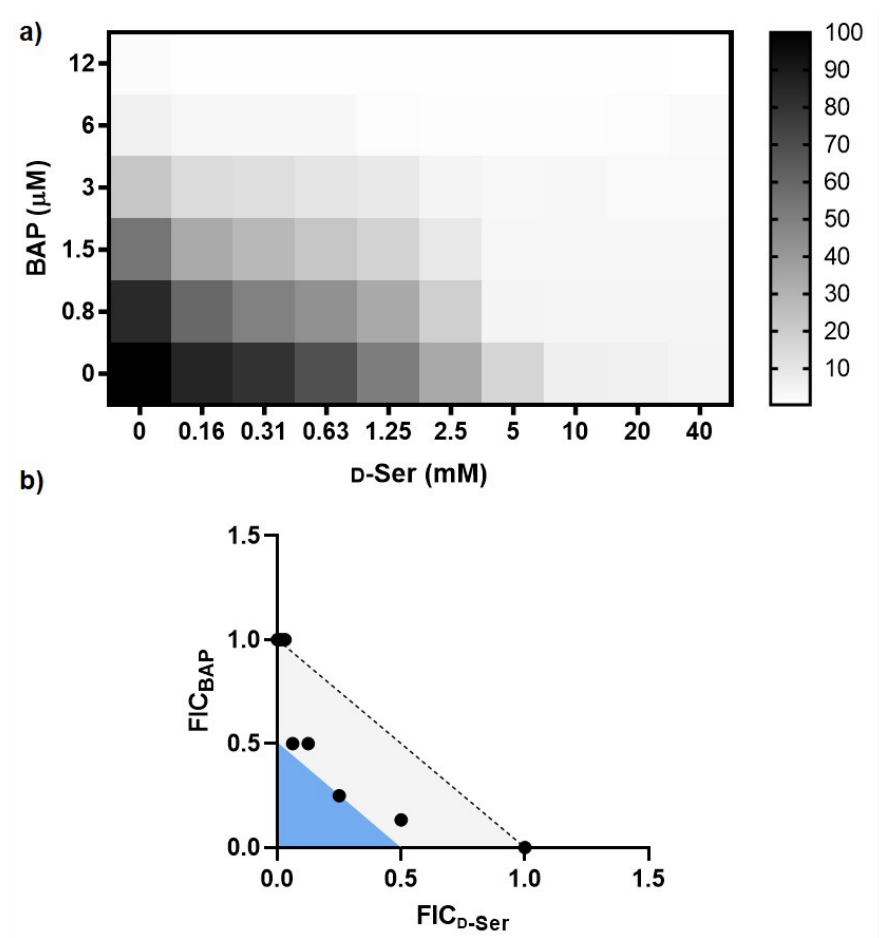
Figure 2. Combining BAP and D -Ser has an additive-to-synergistic effect against UPEC grown in MOPS-glycerol. ( a ) Representative checkerboard analysis with heat plot showing fractional growth at various combinations of BAP and D -Ser; ( b ) Isobologram analysis with points depicting FIC at fractional growth <10%; light gray region indicates additivity (FIC I > 0.5 and <1.0), blue region indicates synergy (FIC I ≤ 0.5). FIC I were observed in the range 0.38–1.06 across experiments for all con- centrations.